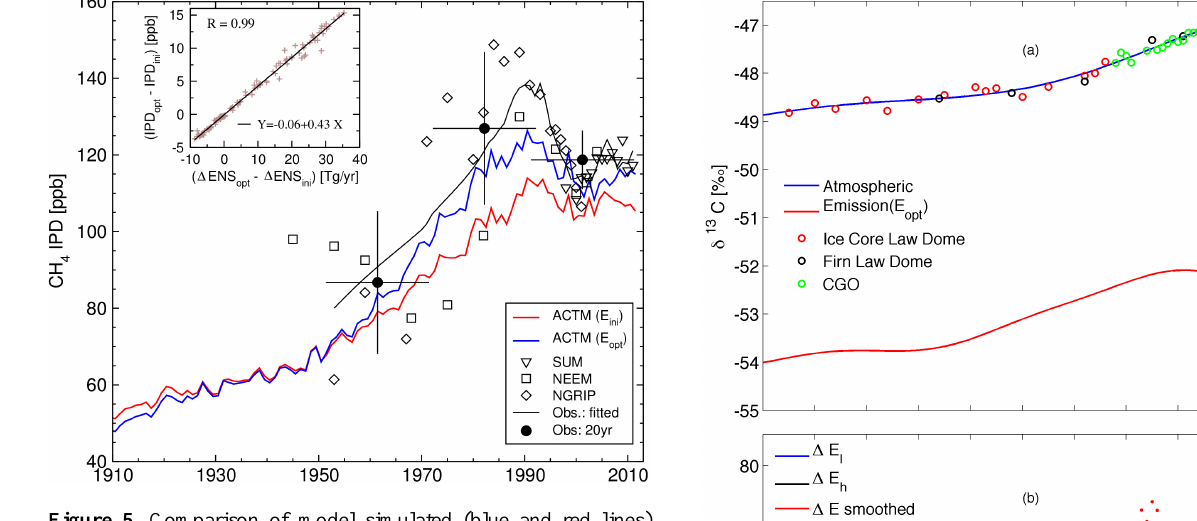
Figure 5. Comparison of model simulated (blue and red lines) and observed (symbols, square) inter-polar differences (IPD) of CH 4 concentration. The black line is obtained by spline fitting the ice core observations from the Arctic and Antarctic regions (ref. Fig. 2). Also shown are the 20-year mean CH 4 IPDs (filled circle), 1- σ standard deviations (vertical bar) and 20-year range for averaging (horizontal bar). Inset: correlation between differ- ence of IPD (IPD opt − IPD int ) and difference of NH–SH emissions ( (cid:49) ENS opt − (cid:49) ENS int ) in optimized and initial guess cases.